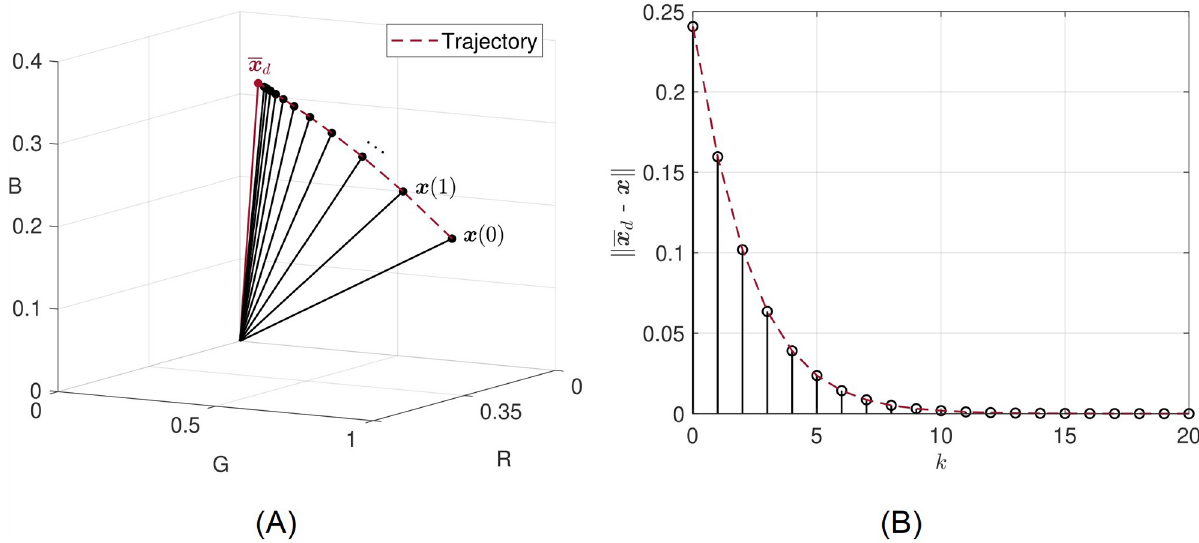
Fig 4. Transient behaviour. (A) A vector x (healthy) converges in norm to � x of their difference.